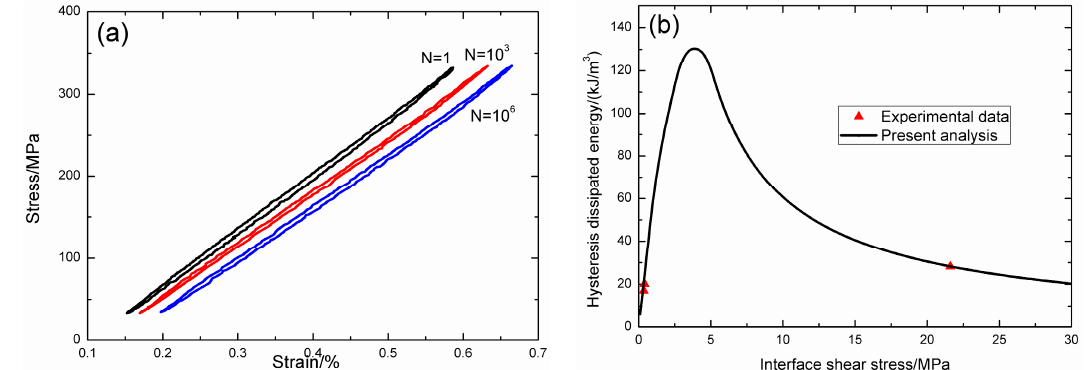
Figure 7. ( a ) The experimental fatigue hysteresis loops corresponding to different cycle number; and ( b ) the experimental and theoretical fatigue hysteresis dissipated energy versus interface shear stress curve of 2D woven C/SiC composite under σ max = 335 MPa at room temperature.